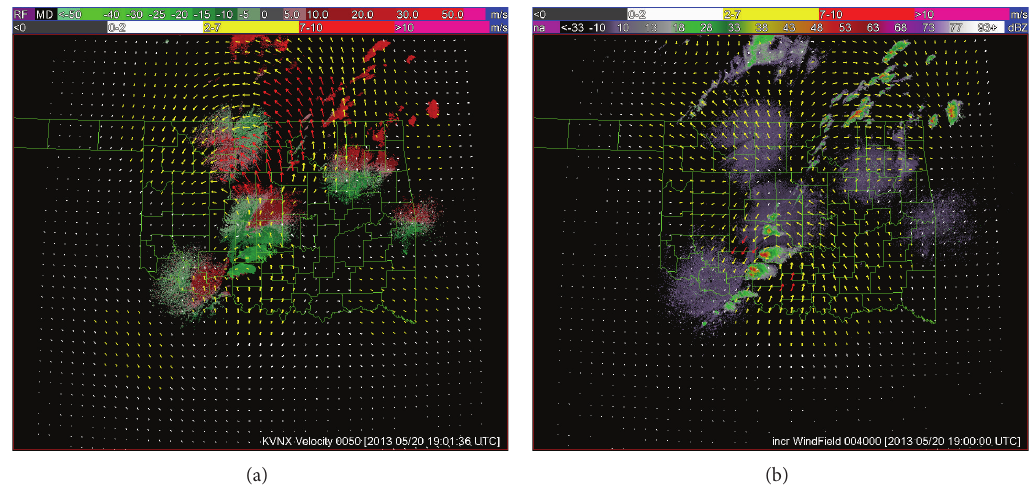
Figure 9: As in Figure 7 but for the incremental winds produced by the upgraded RWAS and plotted by the white ( < 2ms −1 ), yellow (between 2 and 7 ms −1 ), and red ( > 7ms −1 ) arrows with the color scales shown in the second (or first) bar on the top of the first (or second) panel.